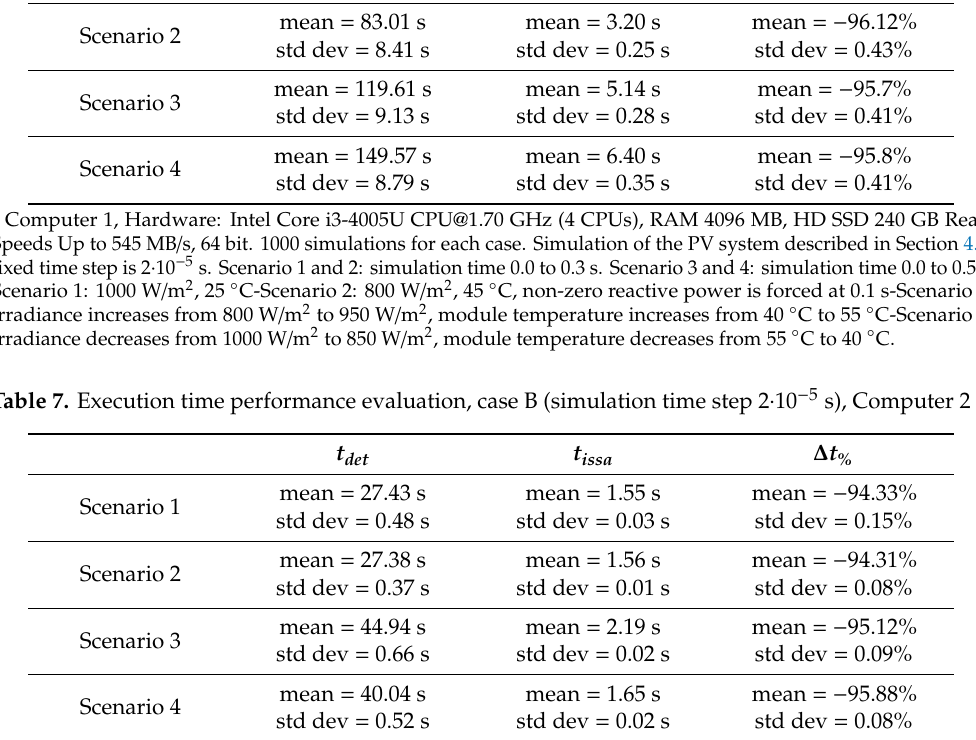
Table 6. Execution time performance evaluation, case B (simulation time step 2 · 10 − 5 s), Computer 1 *. t det t issa ∆ t % Scenario 1